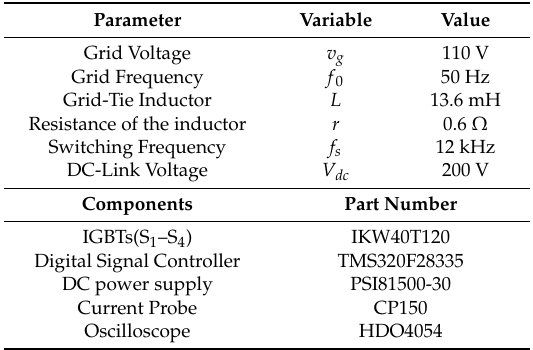
Table 1. Parameters and components of the grid-connected inverter.